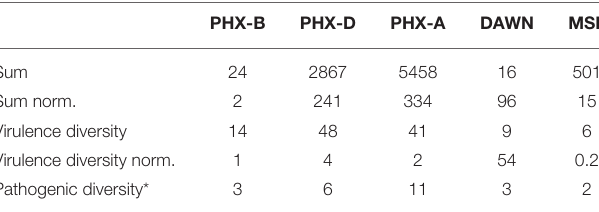
TABLE 4 | Virulence factors with their corresponding pathogens. PHX-B PHX-D PHX-A DAWN